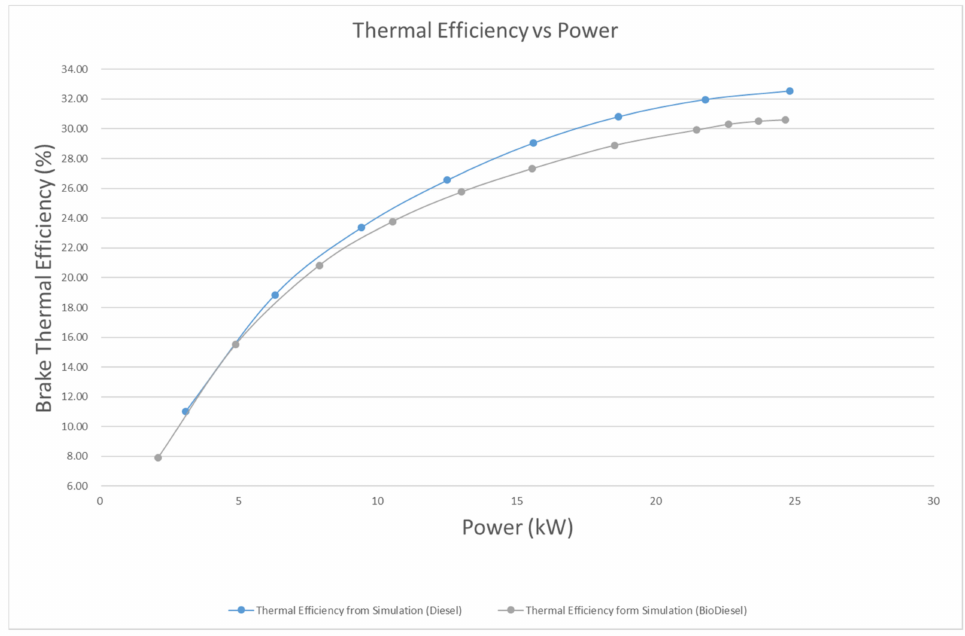
Figure 17. Brake thermal efficiency vs.